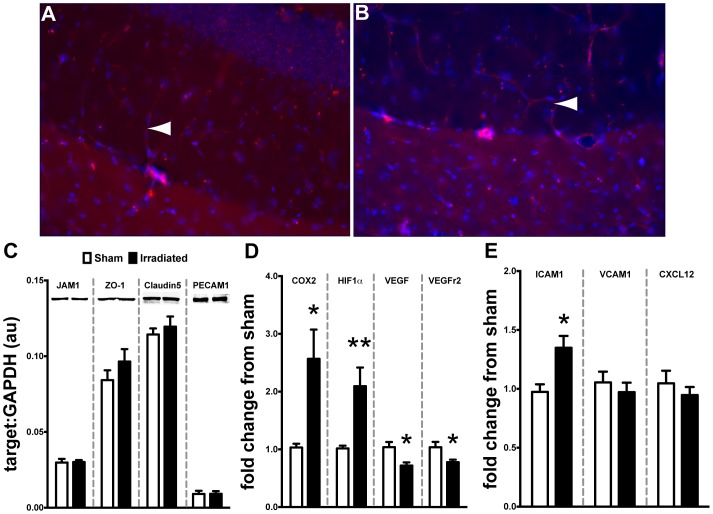
Cranial irradiation does not affect BBB integrity but does alter vascular signaling molecules.Tail-vein injected rhodamine-lectin remained within the vascular compartment without leaking into HPC parenchymal space in either the sham (A) or irradiated (B) treated mice seven days after irradiation. White arrowhead indicate positively stained rhodamine-lectin labeled microvasculature in the dorsal HPC. C. Complementing the lectin experiment, Western blot analysis revealed that 10 Gy of cranial irradiation was not sufficient to alter the expression of JAM1, ZO-1, Claudin5, or PECAM1, which are multiple proteins associated with BBB function (Student’s t-Test; p>0.05). D. There was a significant induction of signaling intermediates associated with vascular function: COX2 (Student’s t-Test; *p<0.05) and HIF1α (Student’s t-Test; **p<0.05) gene expression in the HPC of irradiated WT mice. Conversely, we observed a significant down regulation in gene expression of VEGF (Student’s t-Test; *p<0.05) and its cognate receptor VEGFr2 (Student’s t-Test; *p<0.05). E. Irradiation induced the expression of monocyte associated cellular adhesion molecule ICAM1 in the HPC (Student’s t-Test; *p<0.05) but not VCAM1 or CXCL12 (Student’s t-Test; p>0.05).